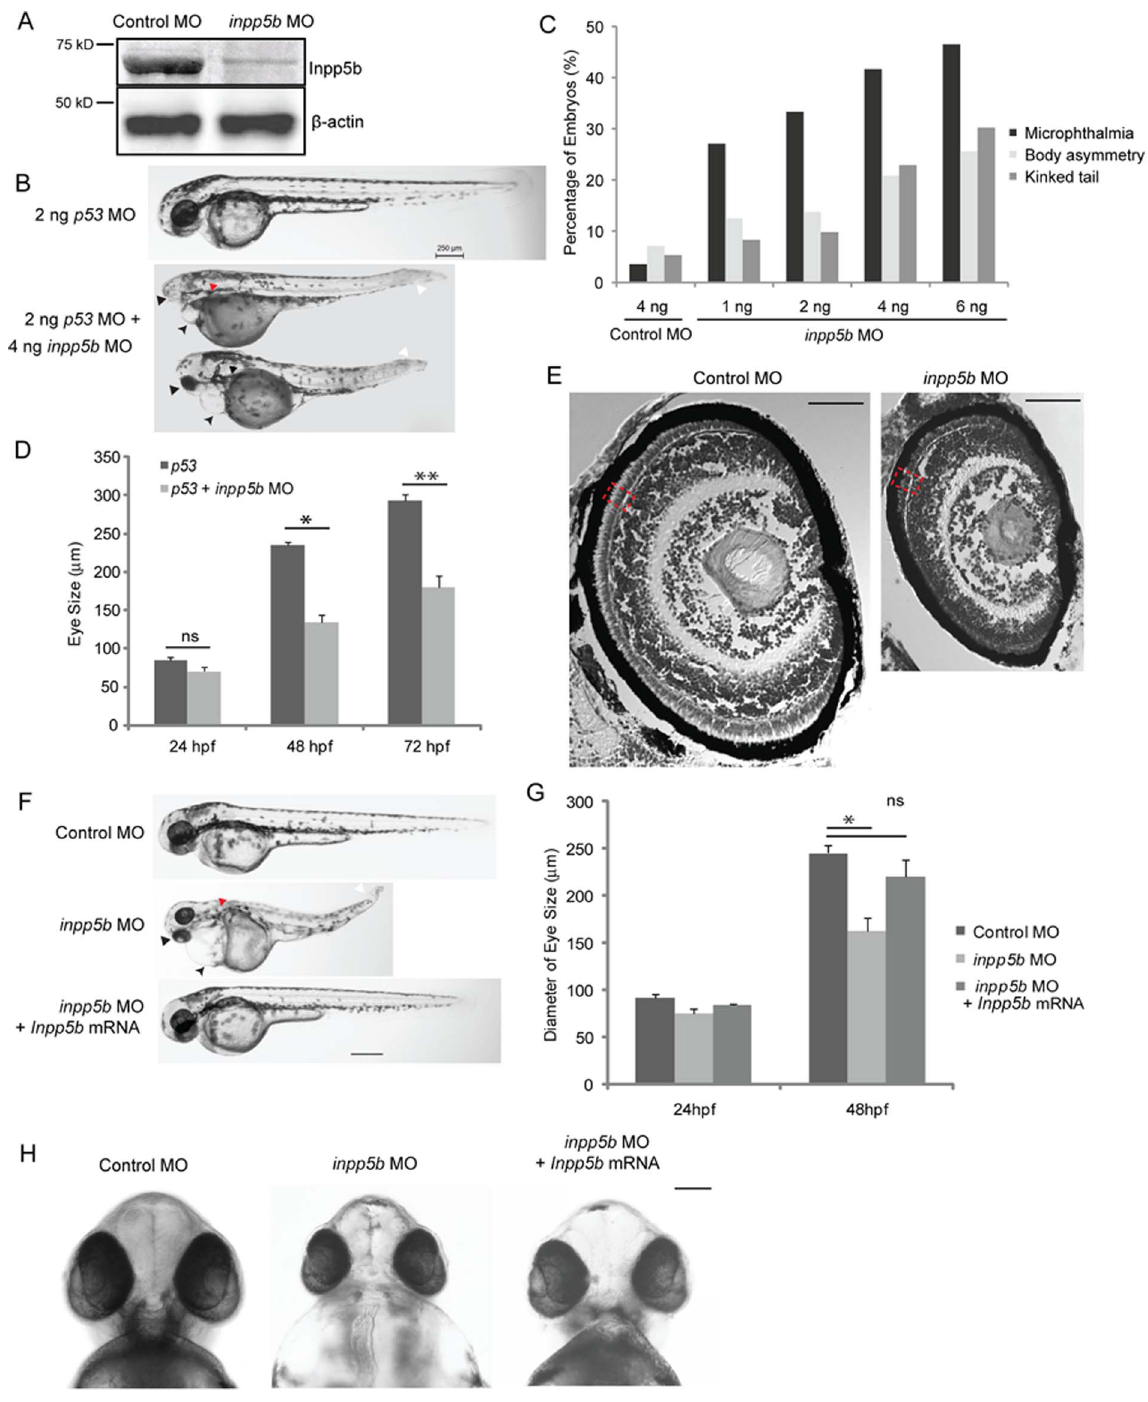
Figure 3. Inpp5b morpholino affects multiple organ development in zebrafish. (A) Immunoblot analysis of 40 microgram of total lysates of zebrafish embryo injected with control MO (4 ng) or inpp5b MO (4 ng) at 48 hpf with anti-INPP5B and anti-beta-actin antibodies. (B) Zebrafish embryos were injected with p53 MO (2 ng) or p53 MO (2 ng) and inpp5b MO (4 ng). Representative phenotypes of microphthalmia (black arrowhead), pericardial edema (small arrow), body axis asymmetry, kinked tail (white arrow), pronephric cyst formation (red arrow), and hypopigmentation were observed at 48 hpf. Scale bar 250 micron. (C) Dose-dependent effect of morpholinos in zebrafish. Control or inpp5b MO at indicated doses was injected into zebrafish embryos, and phenotypes of microphthalmia, kinked tail, and body asymmetry were quantified at 48 hpf (ANOVA, F=92, p=3.6E-10), kinked tail (ANOVA, F=3.6, p=0.08), and body asymmetry (ANOVA, F=5.2, p=0.04). (N=the number of injected embryos N . 50). (D) Quantification of eye size of morphants at 24 hpf, 48 hpf and 72 hpf. The eye size was determined by the longest diameters in dorsal view. (N . 40 embryos, three independent experiments, unpaired t-test, * p=4.98E-07 ** p=2.1E-10, ns, not statistically significant). (E) Cresyl violet staining of ocular sections of zebrafish larvae (5 dpf) injected with control MO (4 ng) or inpp5b MO (4 ng). Scale bar 30 micron. (F) Zebrafish embryos were injected with control MO (4 ng), inpp5b MO (4 ng) or inpp5b MO (4 ng) and Inpp5b WT mRNA ( Inpp5b mRNA, 500 pg). Representative phenotypes of